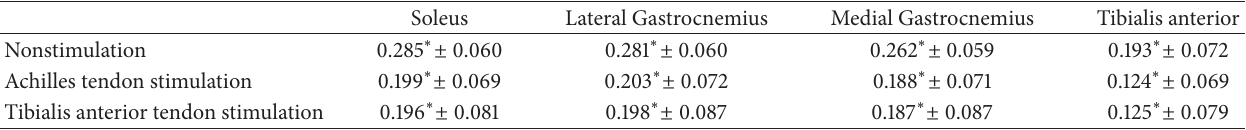
Table 4: The muscle reaction time by the vibration stimulation applied to the Achilles tendon and the tibialis anterior tendon [Sec]. Soleus Lateral Gastrocnemius Medial Gastrocnemius Tibialis anterior Nonstimulation Achilles tendon stimulation Tibialis anterior tendon